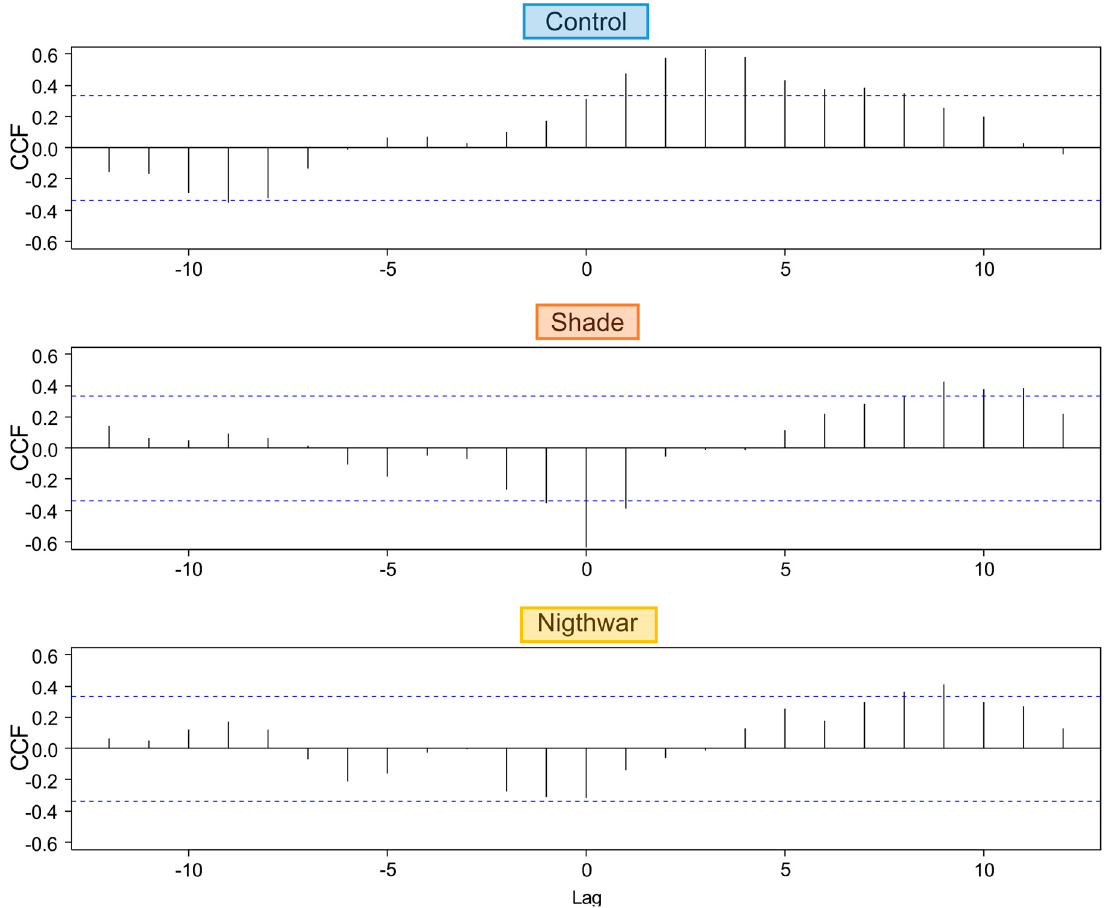
Figure 4. Estimates of the cross-correlation function (CCF), which calculates the cross-covariance of two univariate time series: Air temperature (daily minimum) and Fv/Fm (daily maximum) according to sky-exposure treatments: control (no roof), shade (shade roof during the day), and nightwar = night warming (shade roof during the night). Time series corresponded to 33 days, for air temperature from 28 May to 29 June 2014 and for fluorescence from 29 May to 30 June 2014. The y axis indicates the correlation and the x axis represents the inter-day lag. A positive lag of x days mean that temperature at day t is positively correlated with Fv/Fm on day t + x. Bars passing the dotted blue lines indicate significant correlations between the time series at the respective lag.3.2.2. Mortality